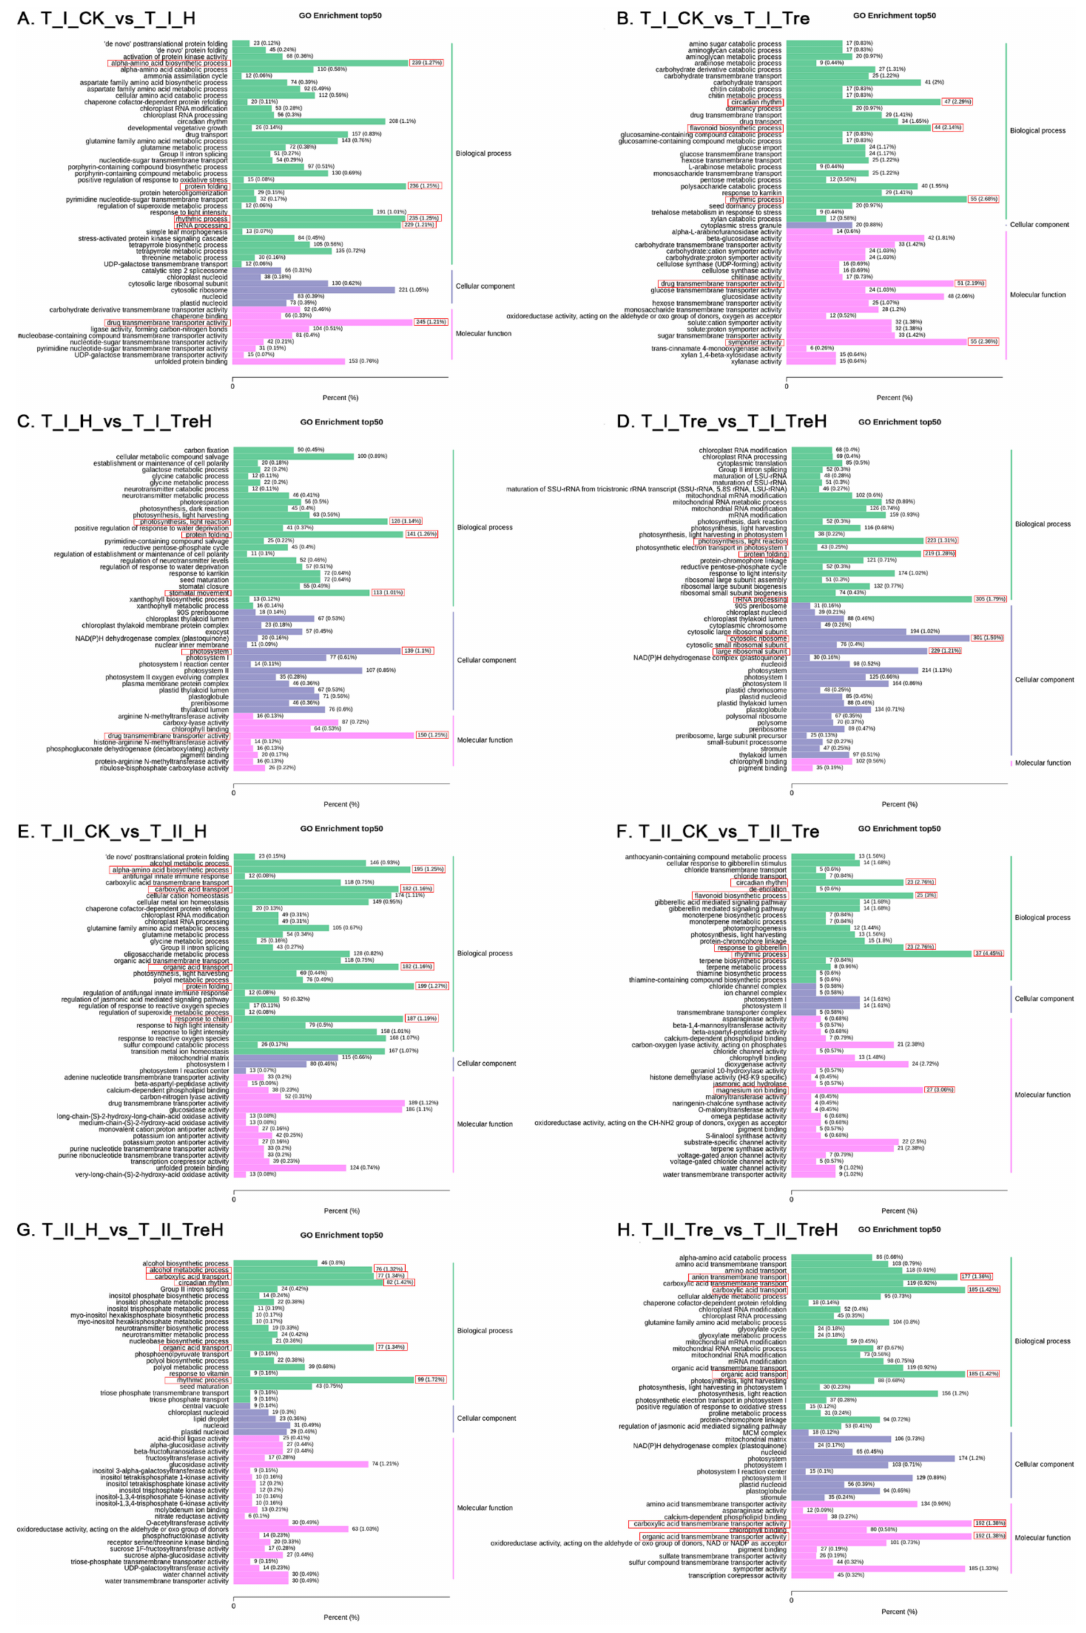
Figure 6. GO enrichment of the DEGs. T—the transcriptome; I—Yangmai 18; II—Yannong 19; CK—control group; H—heat stress treatment for 24 h; Tre—trehalose pretreatment for 3 d;